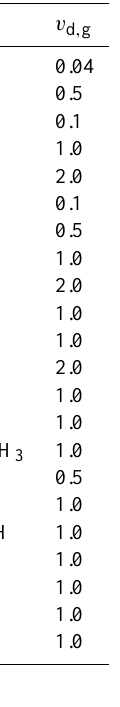
Table 5. Parameters for the non-seasalt aerosol distribution used in study. The total number density, N tot , is given in cm − 3 . The median radius for the log-normal number distribution, R N , is given in µm. The log-normal distribution width, σ , is dimensionless. The log- normal particle number size distribution is calculated according to